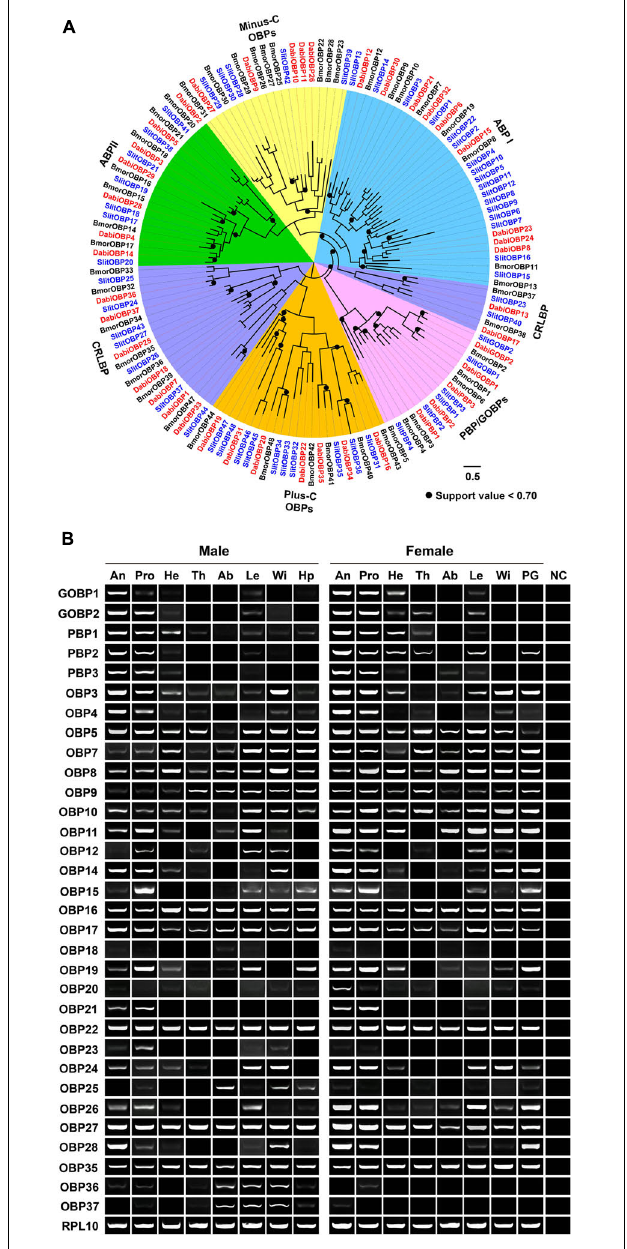
FIGURE 2 | The candidate OBP gene family in D. abietella . (A) The phylogeny of OBPs in S. litura (Slit, blue), D. abietella (Dabi, red) and B. mori (Bmor, black). According to the classification system of OBPs in Lepidoptera, DabiOBPs clustered into six subfamilies. (B) Expression profiles of DabiOBPs in different tissues of both sexes from D. abietella . A reference gene, DabiRPL10 , was used to check the quality and quantity of cDNA templates. NC, negative control using sterile water as the template. The full names of tissues are listed in Table 1